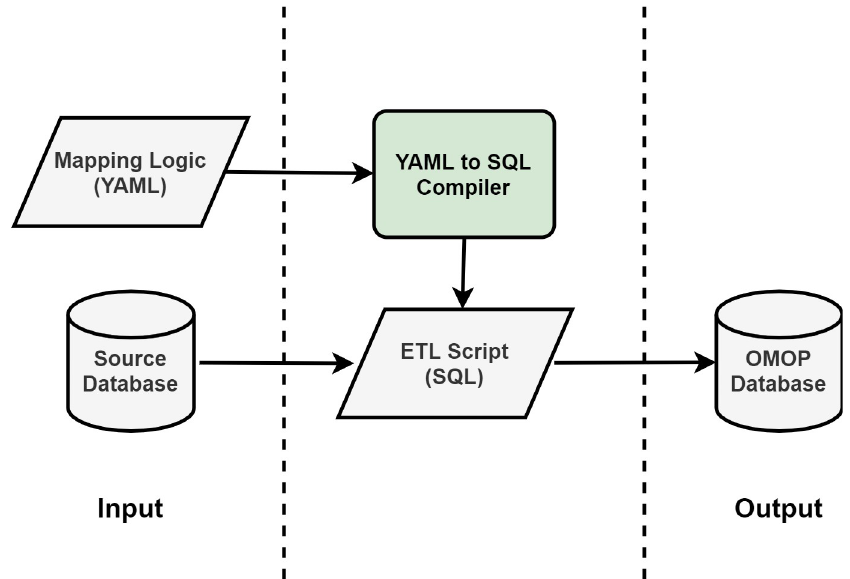
Fig 1. Architecture of the extract, transform, load (ETL) framework. A compiler converts mapping logic, written by organizing SQL snippets in YAML key-value pairs, to an ETL SQL script, which contains all the executable operations to map from the source database to